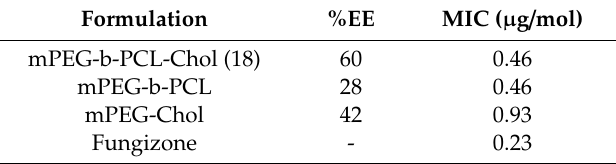
Table 4. Encapsulation e ffi ciency and Minimum Inhibition Concentration (MIC) of the three formulations.